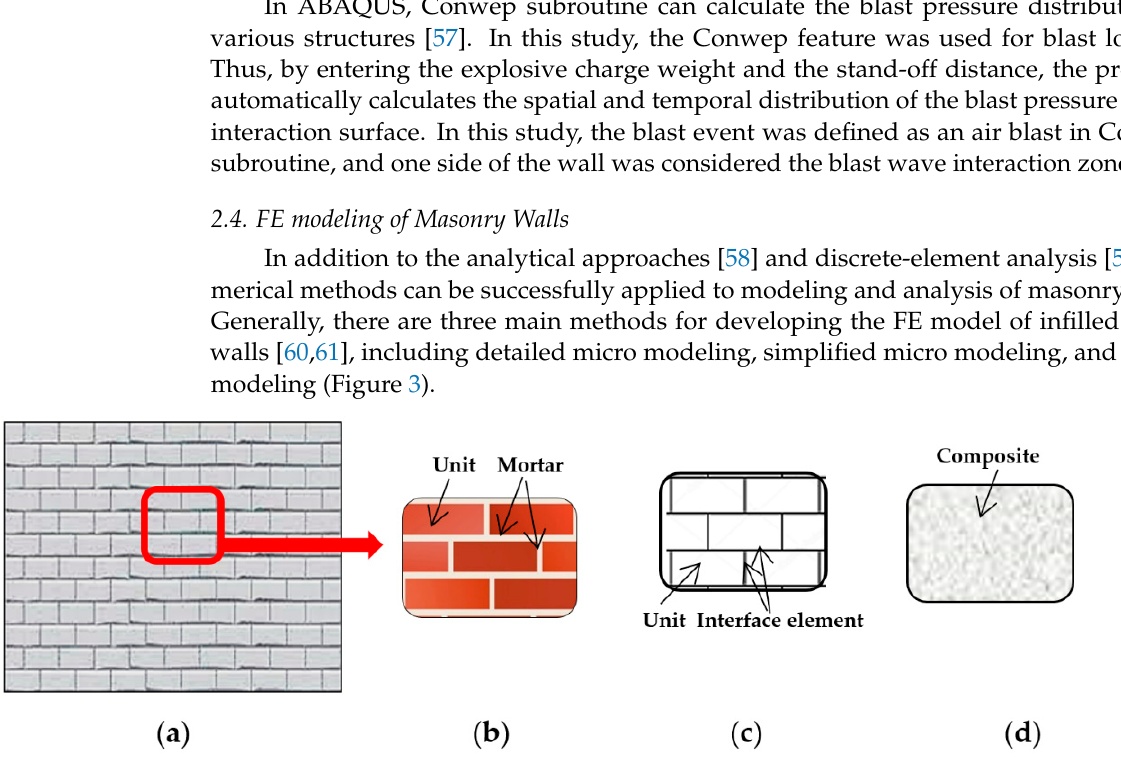
Figure 3. Masonry wall modeling approaches: ( a ) a real masonry wall; ( b ) accurate detailed micro modeling; ( c ) simplified micro modeling; ( d ) macro modeling.